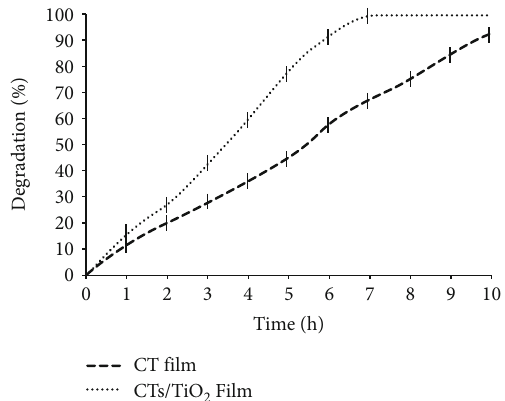
-NPs from their 2 Figure 5: The hydrodegradation patterns of prepared fi lms from nanochitosan (CTs fi lm) and its composite with TiO fi lm). ∗ Values are mean of triplicates with the (CTs/TiO 2 illustrated error